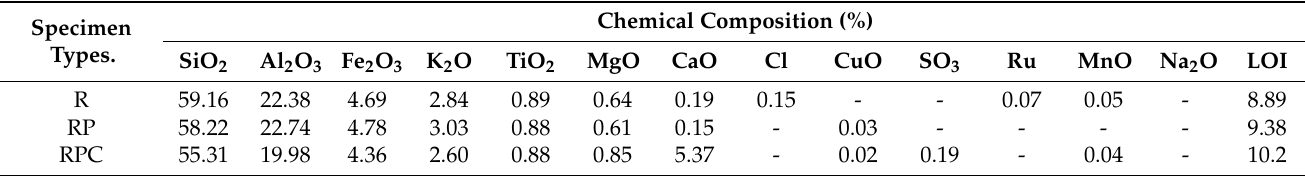
Table 4. X-ray fluorescence analysis after adding the polymer aqueous solution. Specimen Types.